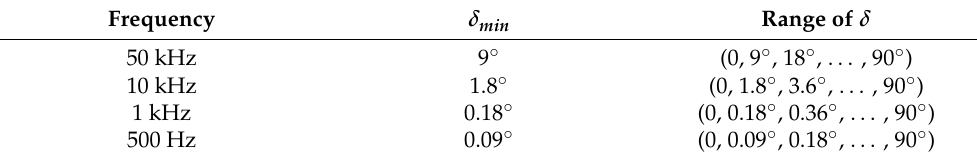
Table 1. Smaller phase shift δ min for frequency of the DAB converter for t sample = 0.5 µ